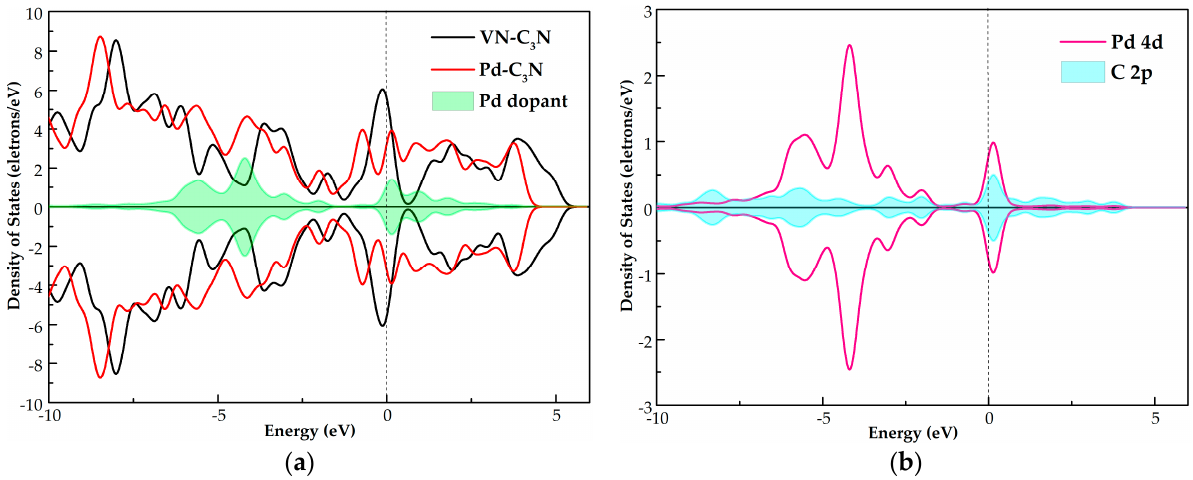
Figure 3. ( a ) TDOS of the VN-C 3 N monolayer, Pd-C 3 N monolayer, ( b ) PDOS of the Pd-C 3 N monolayer, the dotted line indicates the Fermi